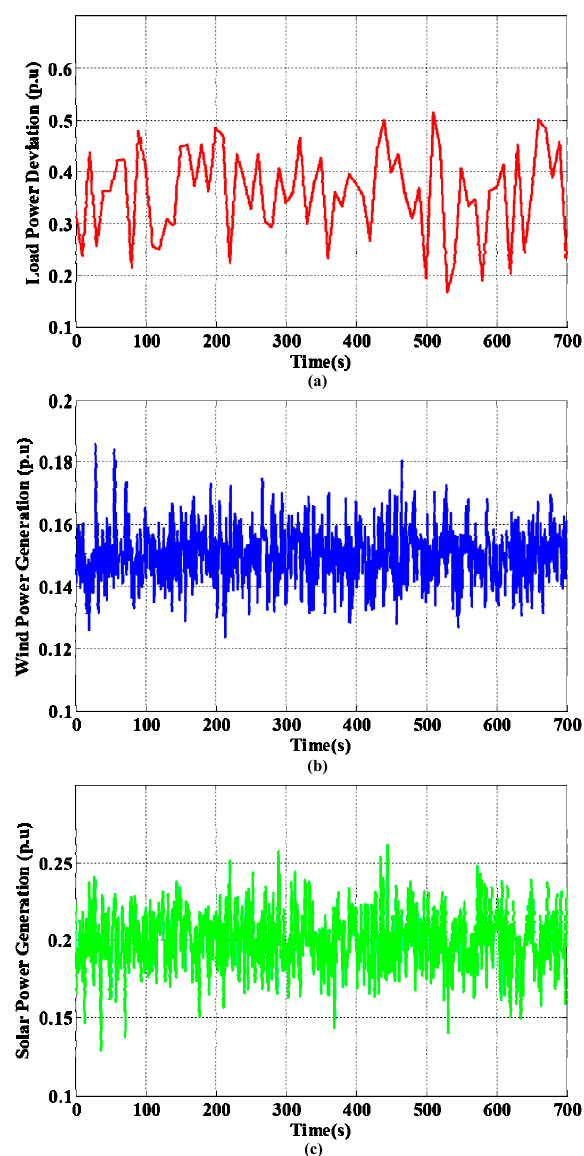
Figure 13. MG disturbances for Section 5.2.2. ( a ) Random load deviation. ( b ) WTG output power. ( c ) PV output power.